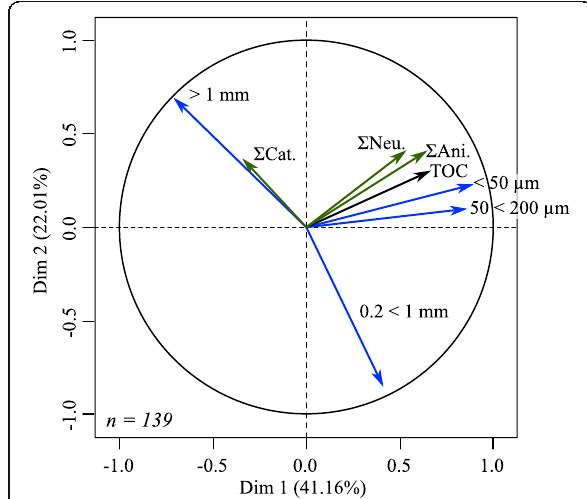
Fig. 6 Principal component analysis performed with the sum of the concentrations of cationic ( ∑ Cat.), anionic ( ∑ Ani.) and neutral ( ∑ Neu.) DTRs and the grain size (> 1 mm, 0.2 < 1 mm, 50 < 200 μ m and < 50 μ m respectively) and the total organic carbon